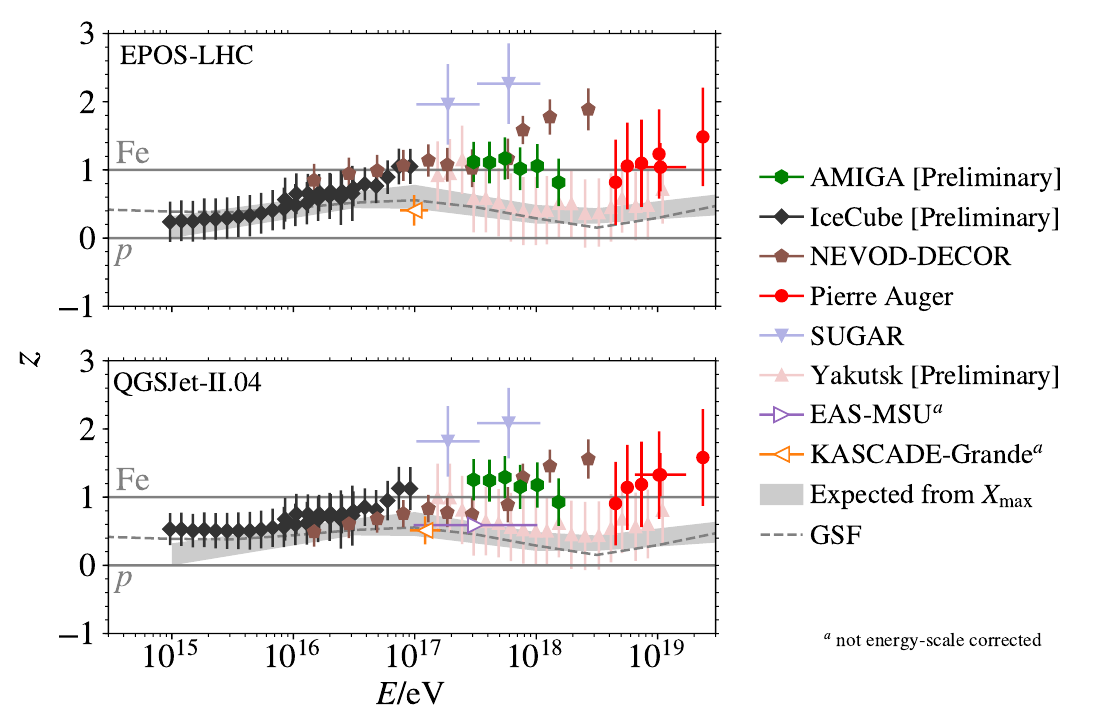
Figure 8. Zoom into Fig.7 for EPOS-LHC and QSGJet-II.04. The points for KASCADE-Grande and EAS-MSU cannot be cross- calibrated and are only included for comparison.